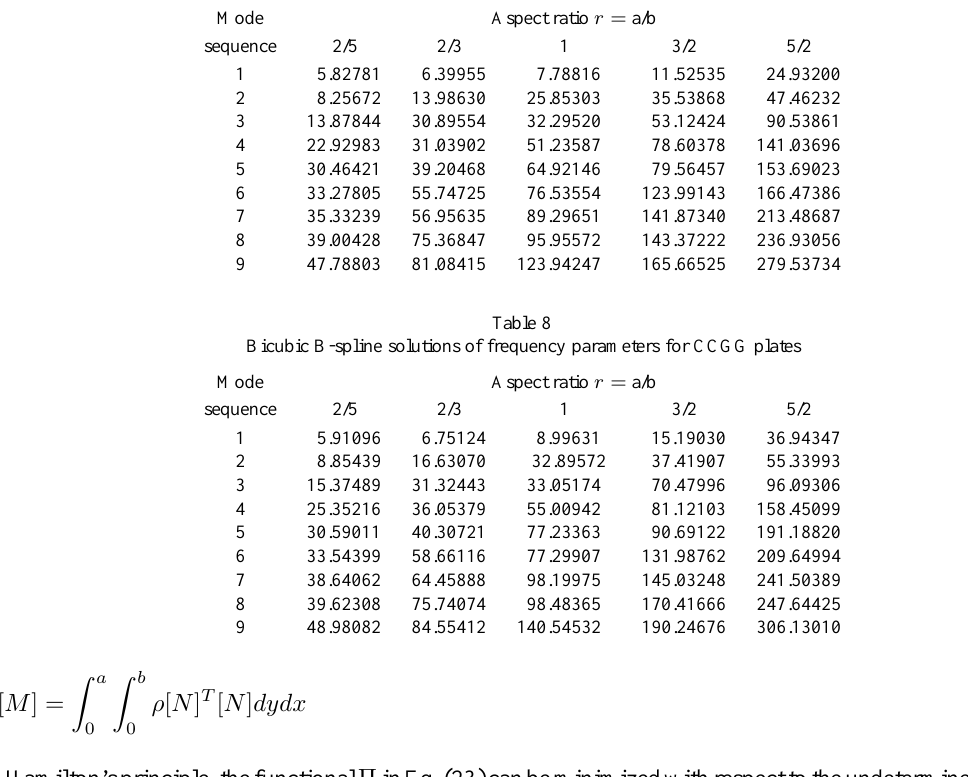
Table 7 Bicubic B-spline solutions of frequency parameters for CCGF plates